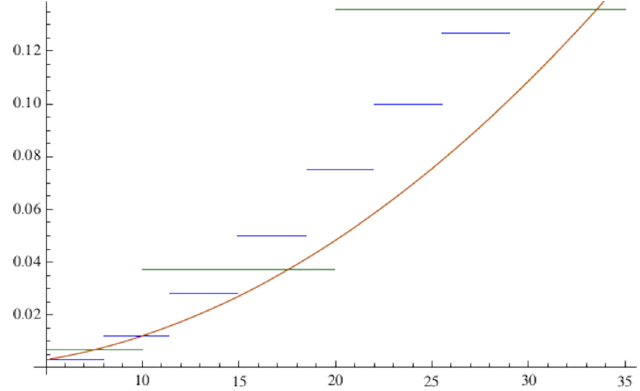
Figure 5 . Comparison of prediction (7.30) with lines depicting angular coefficient A 2 in bins of Q ⊥ and Y < 1 from ref. [18]. (long bins) and [17] (short